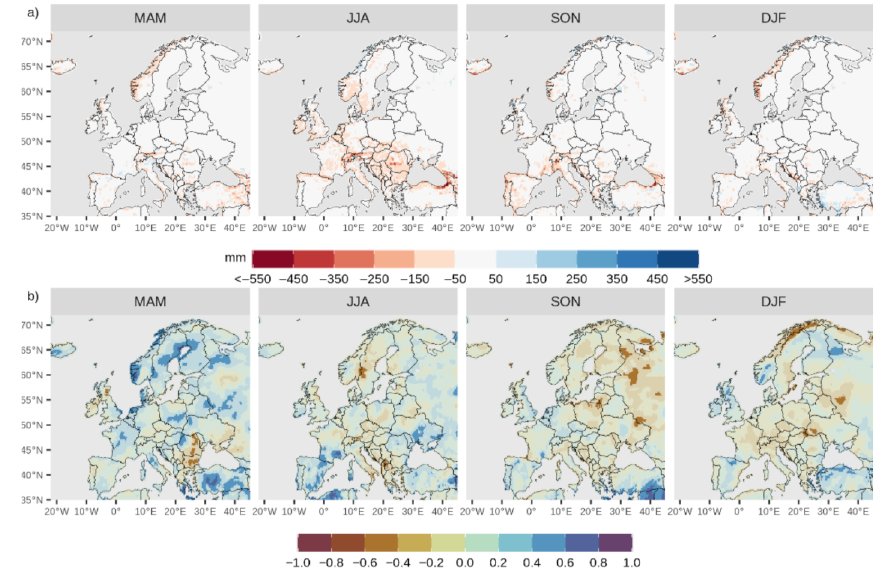
Figure 4. Spatial distribution of ( a ) ME and ( b ) CORR for unadjusted ECMWF SEAS5 ensemble forecasts of precipitation (one-month lead time) over Europe (land only) with respect to ERA5 reanalysis over 1993–2016. Significant correlation ( p -value < 0.05) is reported by unshaded